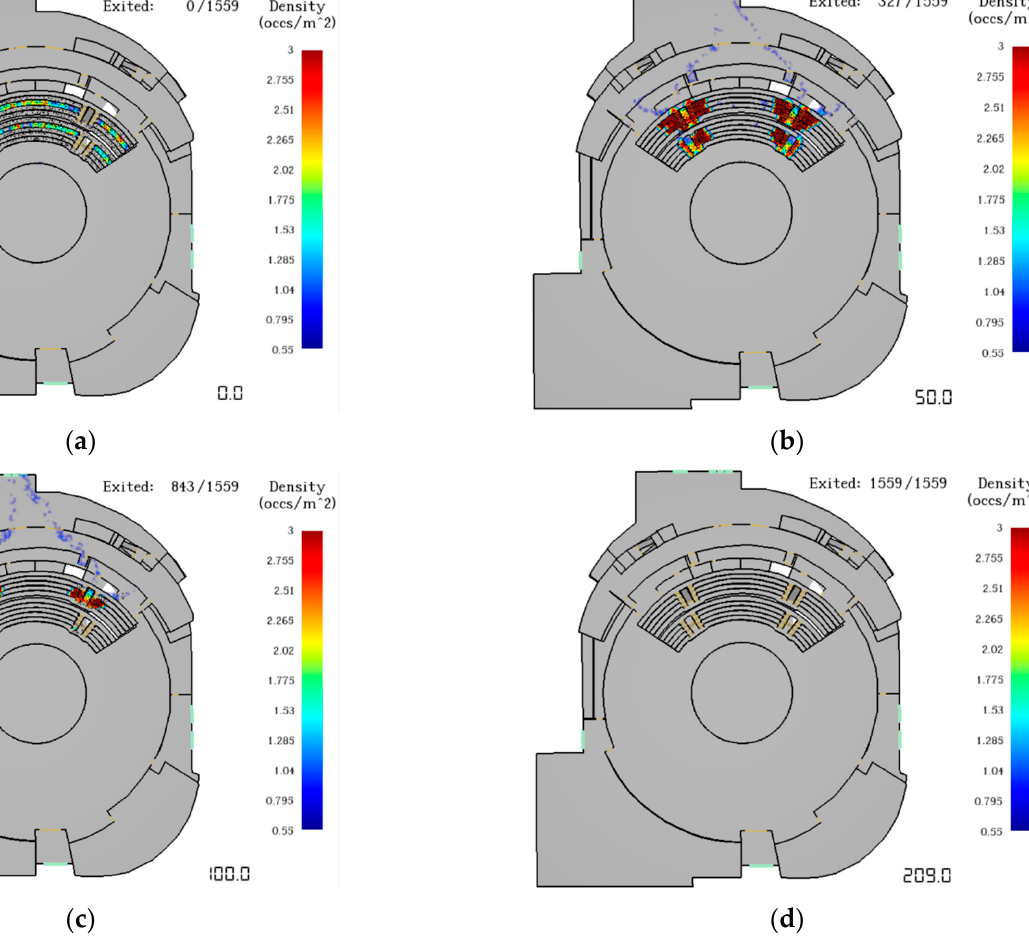
Figure 19. Evacuation process and density distribution of the occupants on the first floor. ( a ) Occupant density at 0 s; ( b ) occupant density at 50 s; ( c ) occupant density at 100 s; ( d ) occupant density at 209.0 s.